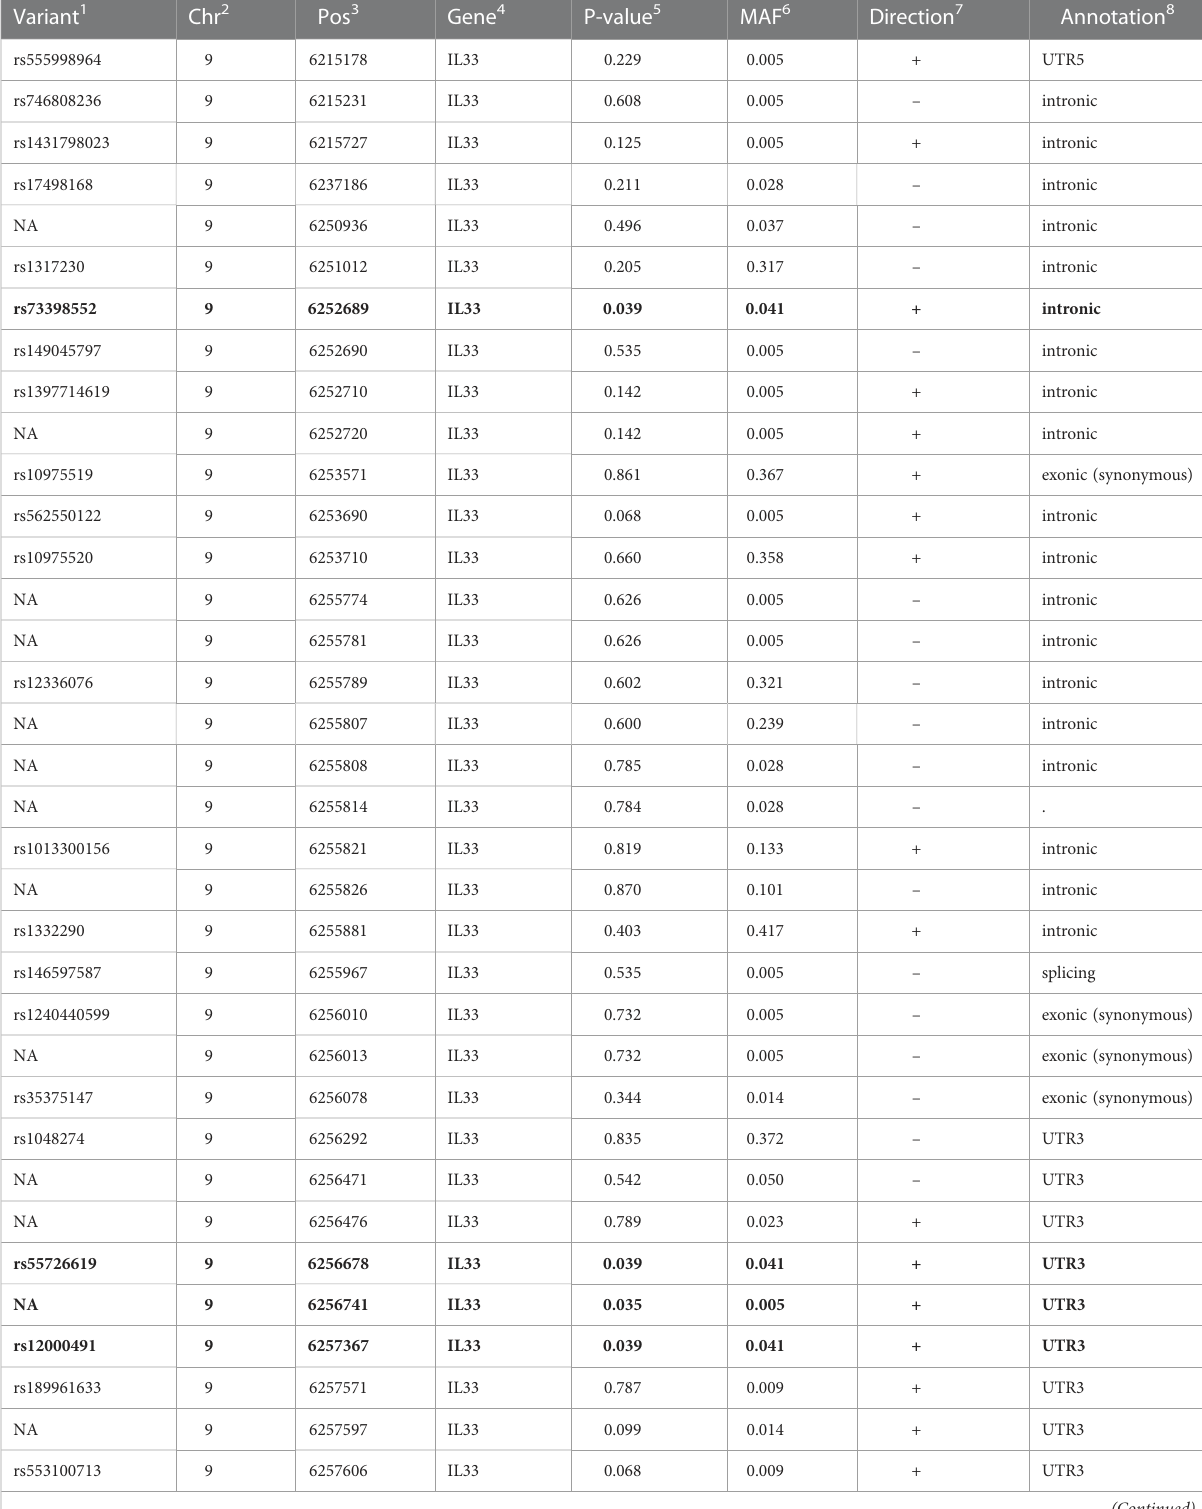
TABLE 4 Single variant results for